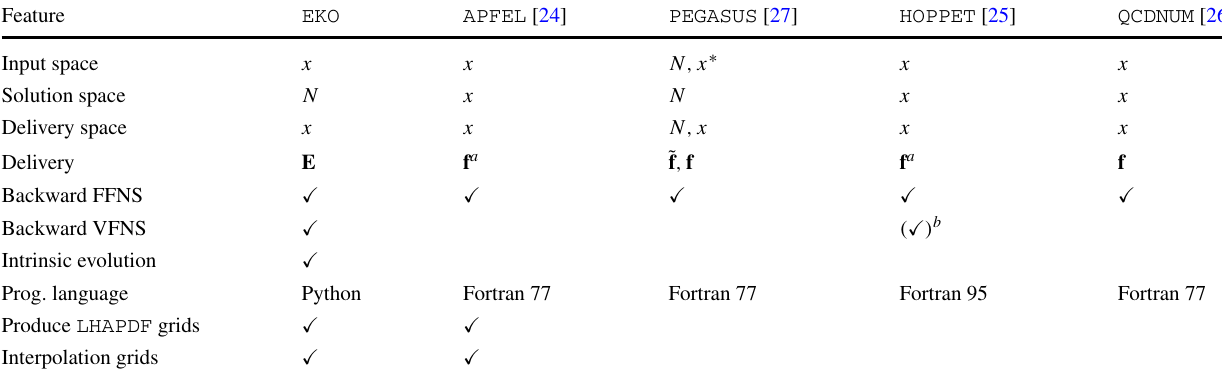
Table 1 Comparison between several evolution programs. The upper part of refers to some physical features: by x we mean the momentum fraction, N the Mellin variables, x ∗ denotes that PEGASUS is able to deal with x -space input, but only for fixed PDF parametrization (see